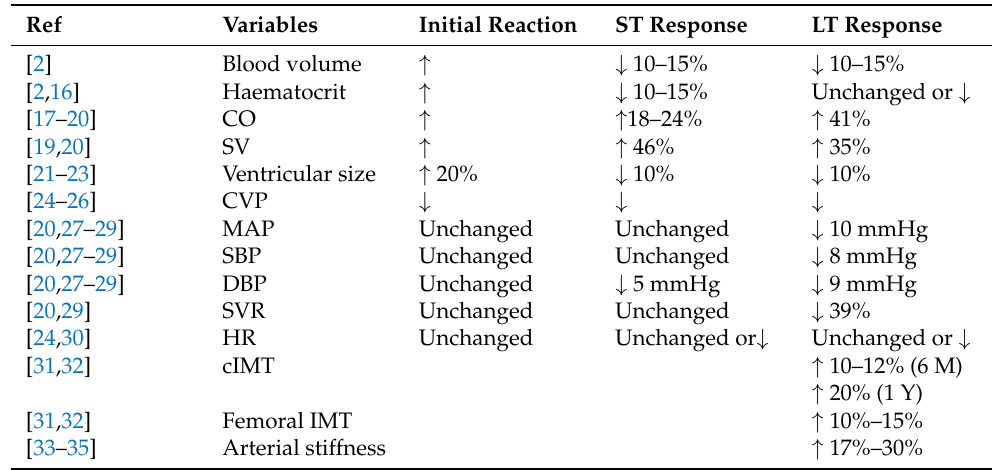
Table 1. Microgravity-induced cardiovascular